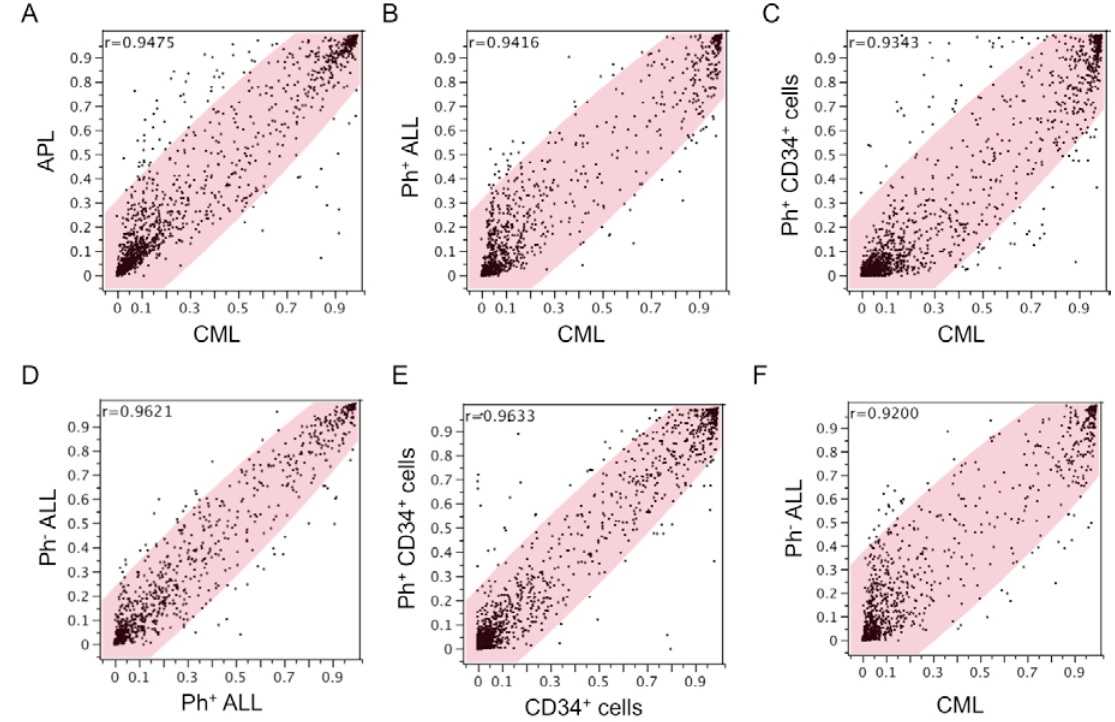
Figure 4: Direct comparison of DNA methylation profiles for different leukemias. DNA methylation profiles were compared for various leuke- mias (CML, APL, Ph + ALL, Ph - ALL, Ph - CD34 + , and Ph + CD34 + cells). Scatter plots were generated for direct comparisons of mean methylation beta values. (A) CML with APL (r=0.9475), (B) CML with Ph + ALL (r=0.9416), (C) CML with Ph + CD34 + cells (r=0.9343) (D) Ph + ALL with Ph - ALL (r=0.9621), and (E) Ph + CD34 + cells with Ph - CD34 + cells (r=0.9633), and (F) CML with Ph - ALL